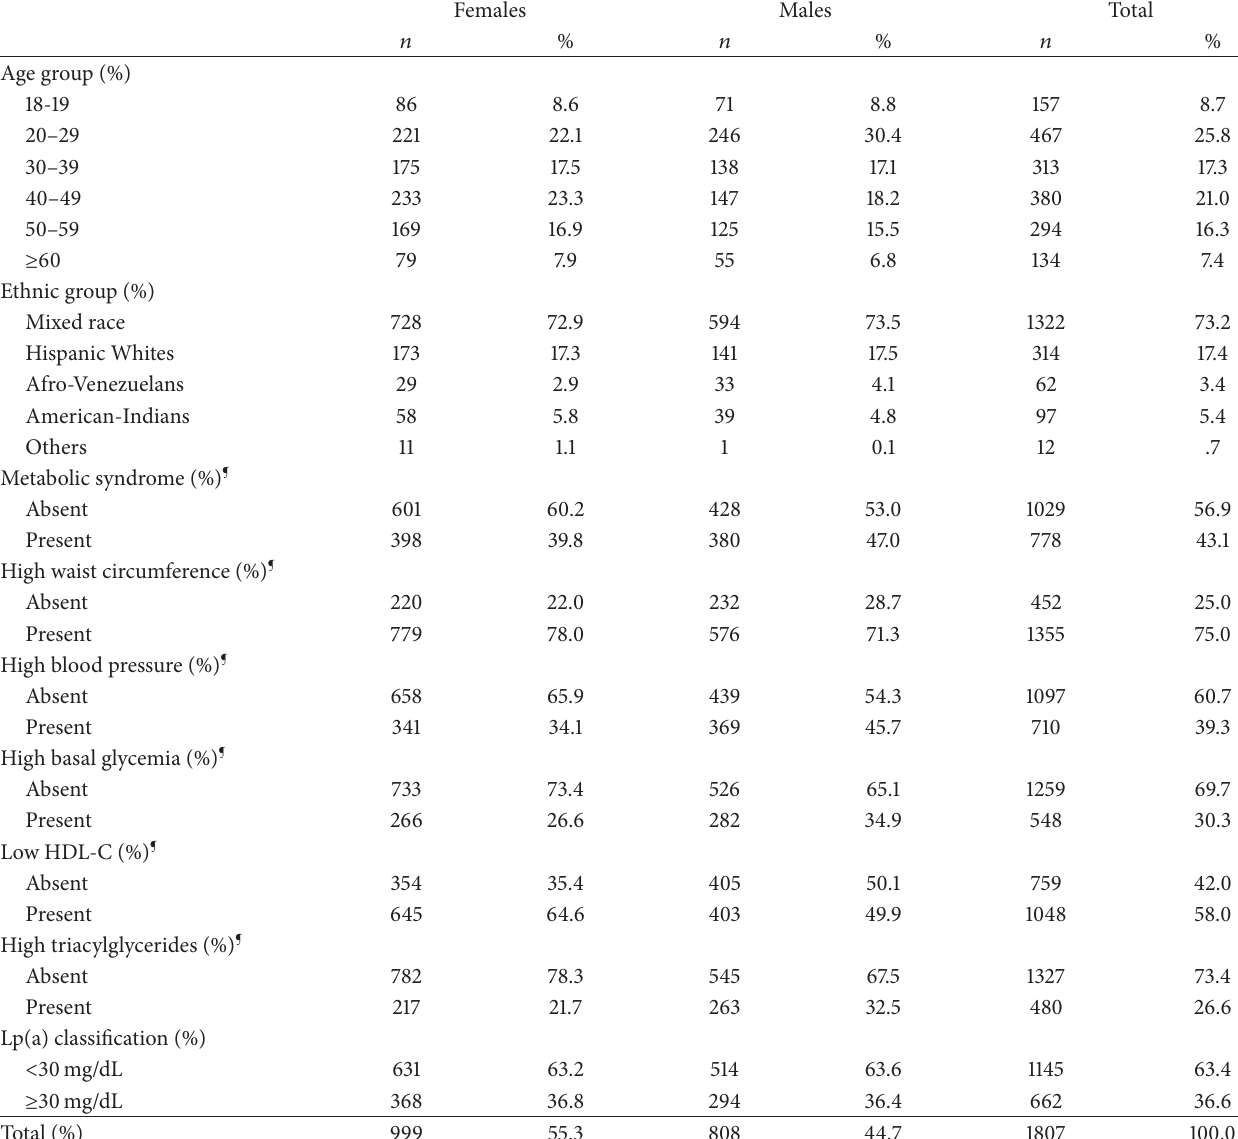
Table 1: General characteristics of the population evaluated by gender. The Maracaibo City Metabolic Syndrome Prevalence Study, 2013.